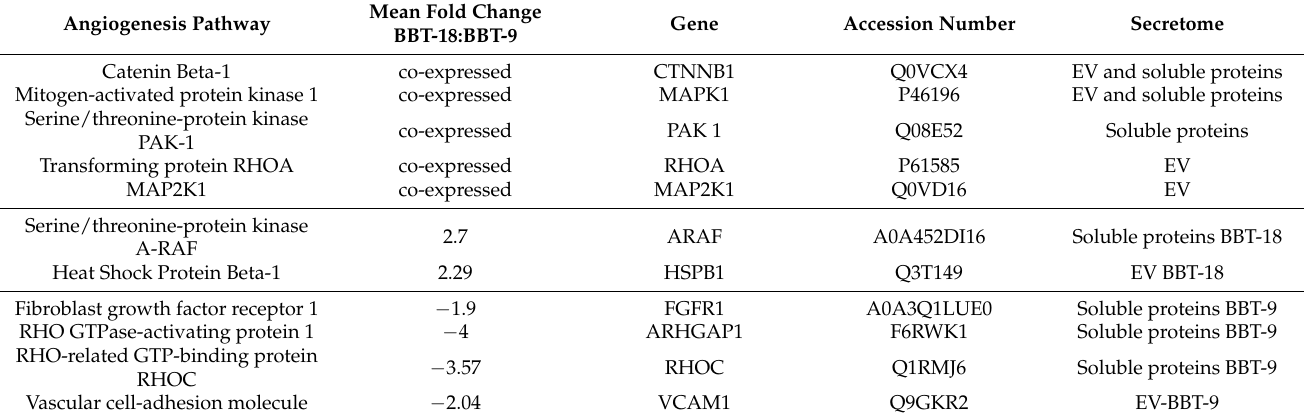
Table 4. Angiogenic proteins expressed in the soluble fraction and EV-cargo from BBT-secretome, detected by iTRAQ-LC- MS/MS